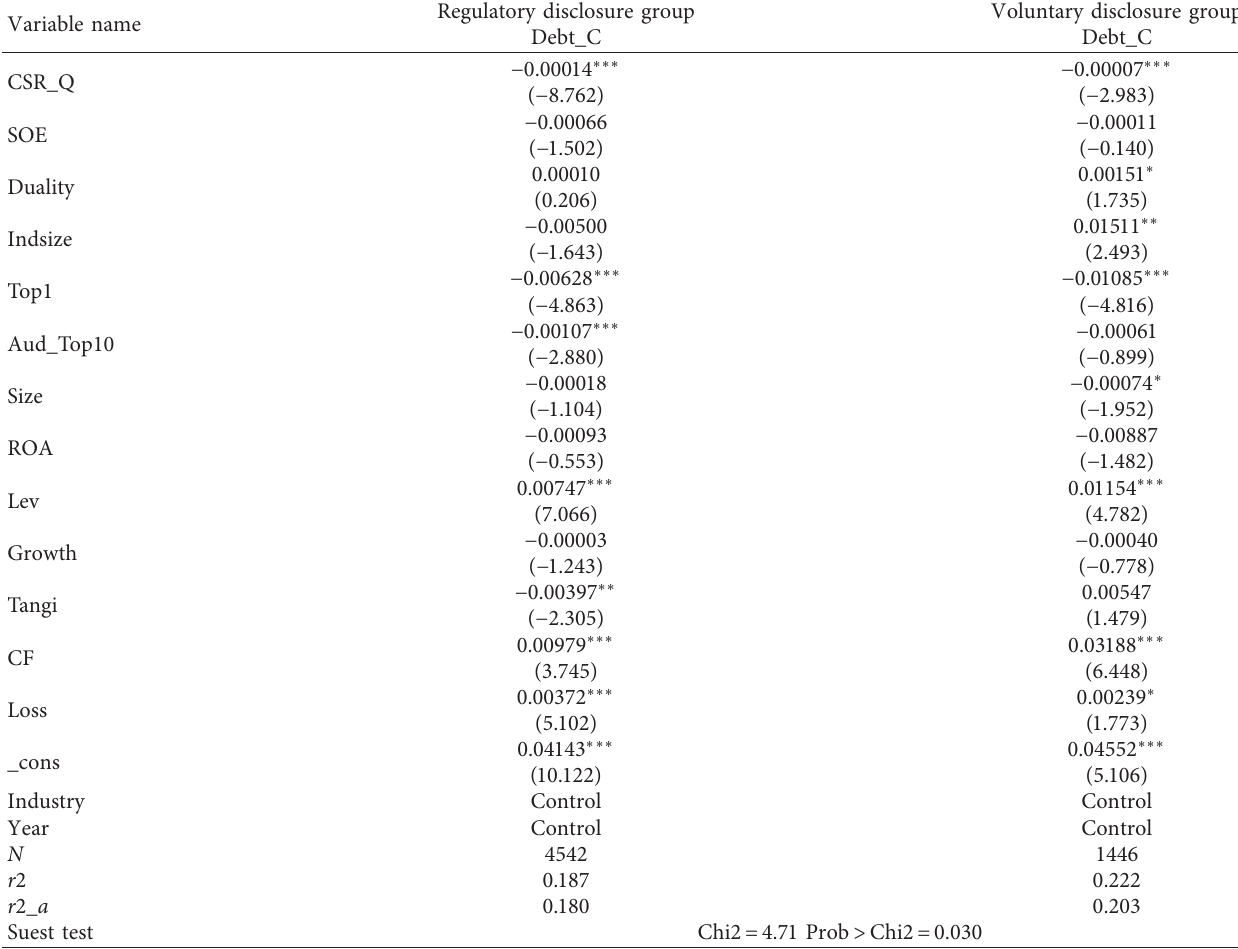
Table 6: Quality of social responsibility disclosure and cost of debt financing: analysis based on the form of